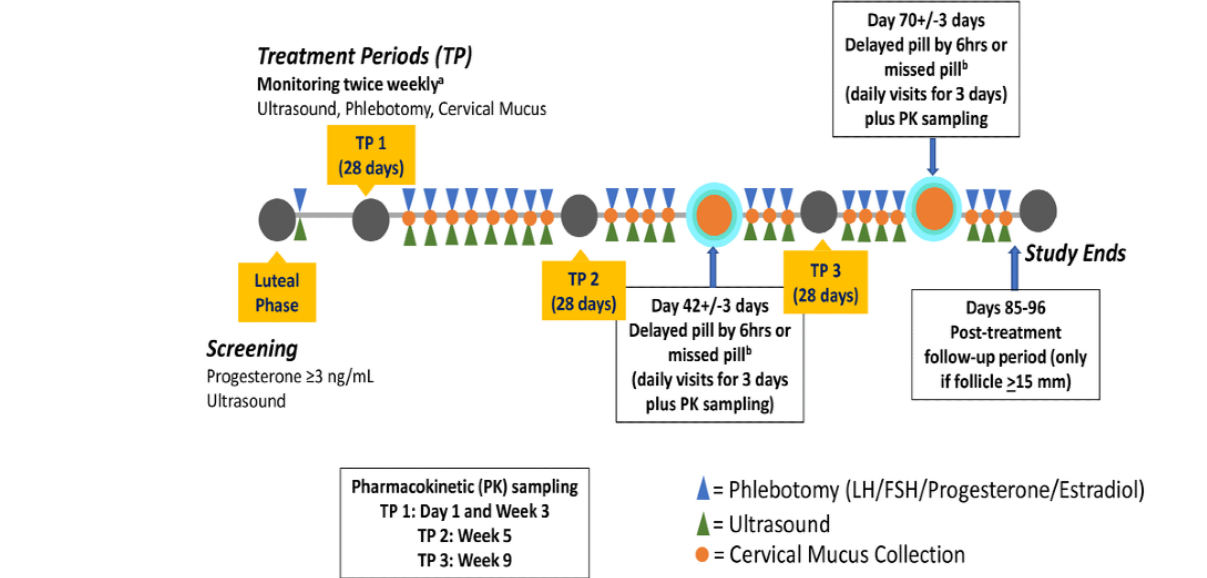
Figure 2. Study Procedures. a If follicle is ≥ 15mm, then visits are changed to every other day for 3 extra visits; b Three consecutive visits at the time of delayed/missed